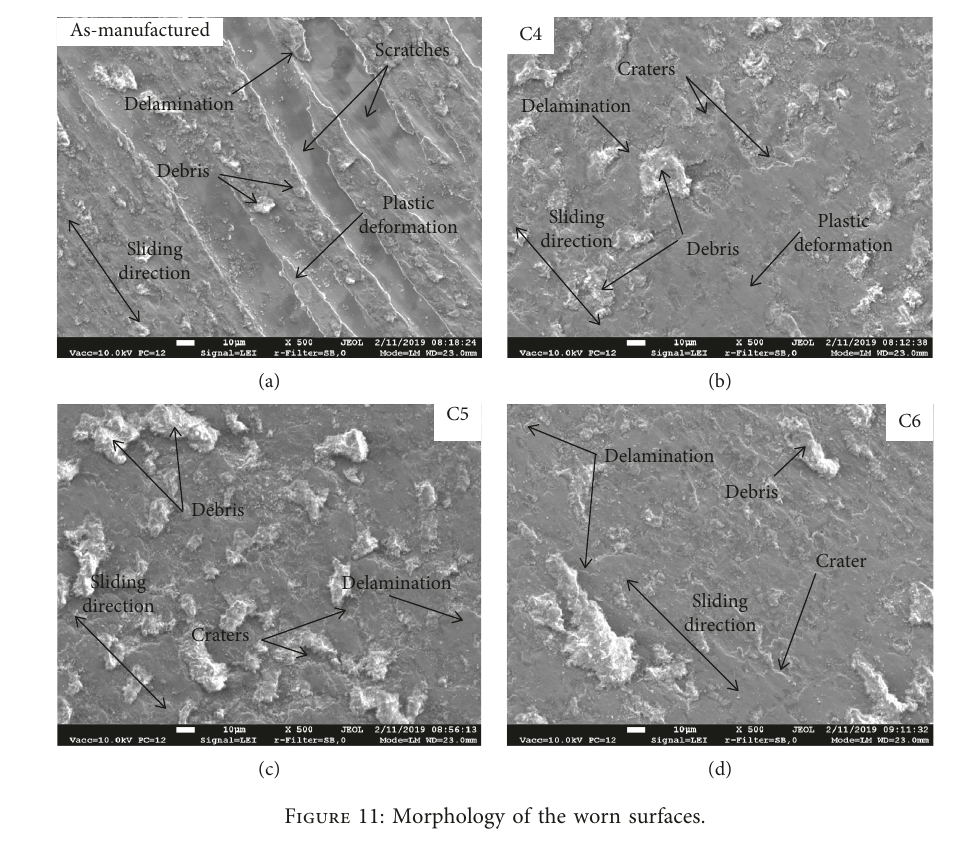
Figure 11: Morphology of the worn surfaces.